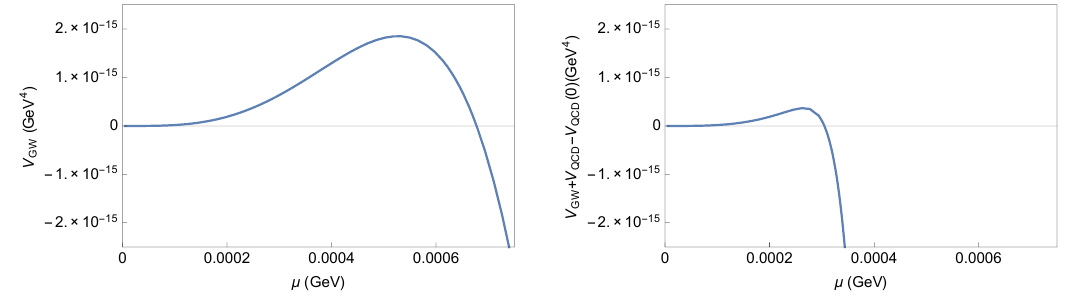
Figure 2 . The radion potential plotted around the Goldberger-Wise barrier without (left) and with (right) the contribution from the gluon condensate for (cid:22) min = 2 : 5 TeV, n = 0 : 15, n c = 3, (cid:15) = 1 = 20, v IR = 1 and (cid:14) = (cid:0) 1 = 2. The combined potential is negative near the origin because the gluon condensate contributes with a negative sign, while the Goldberger-Wise potential vanishes there. For better comparison, we have shifted the combined potential to make it vanish at the origin too. Notice that the barrier does not completely disappear even with the contribution from the gluon